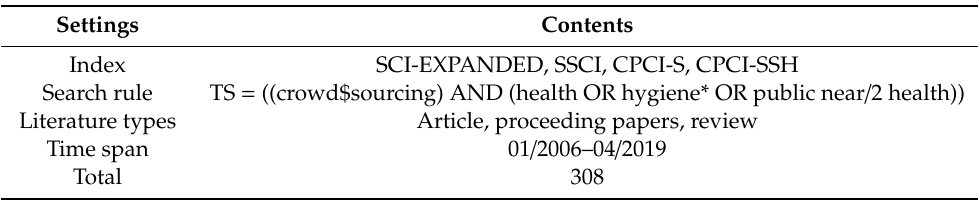
Table 1. Summary of search